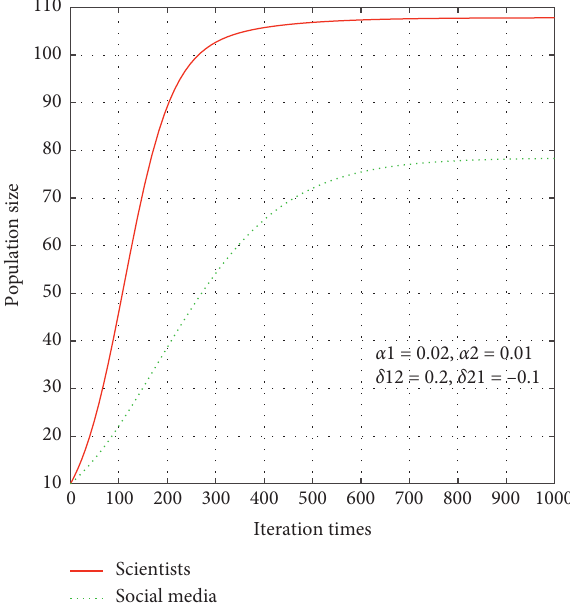
Figure 5: Parasitic coexistence pattern. Changes in the size of the two populations after 1000 iterations ( α � 0 . 01 δ � 0 . 2, and δ � − 0 . 1). α 2 12 21